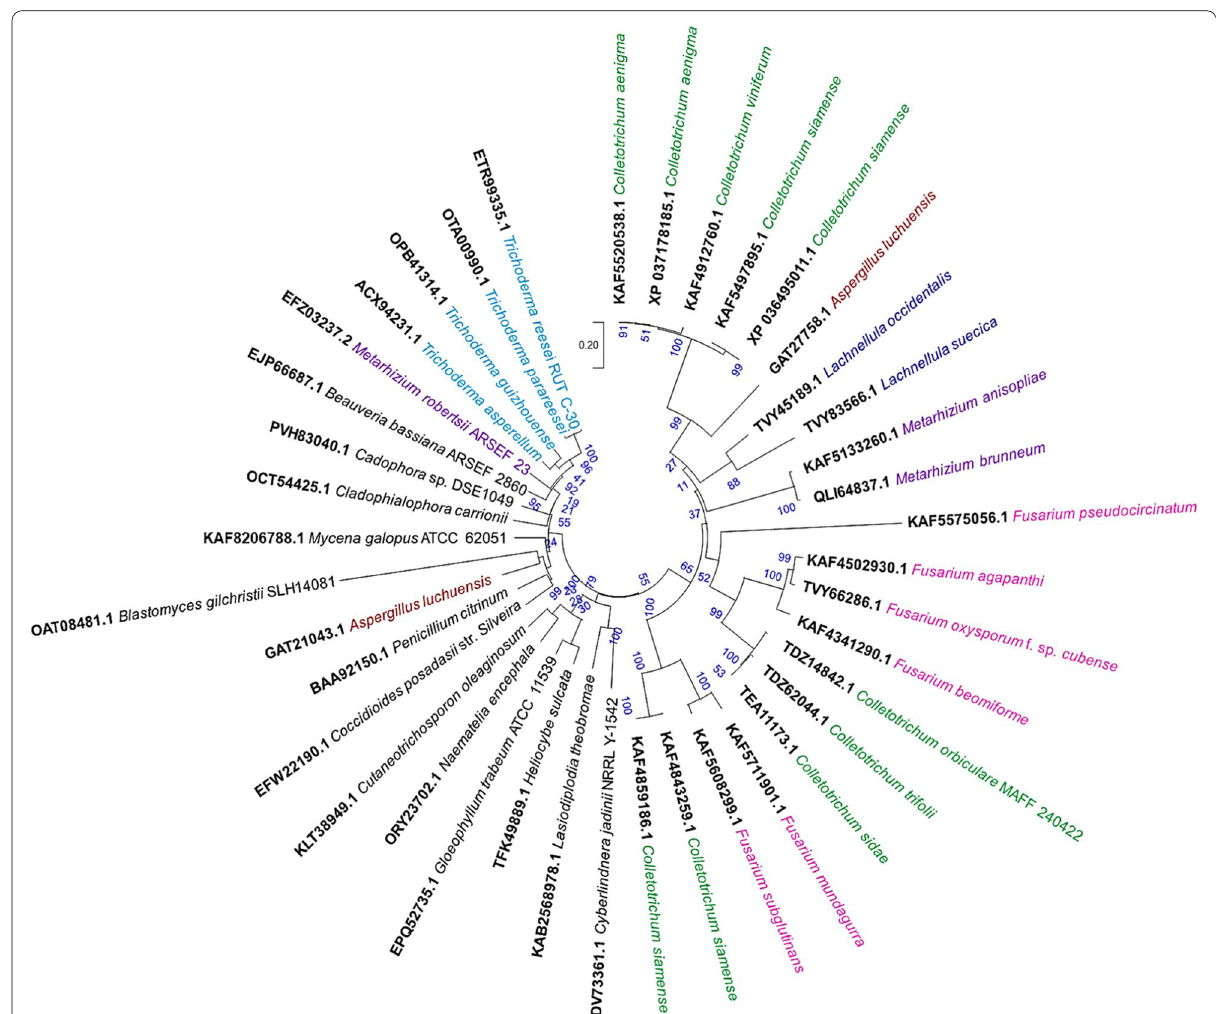
Fig. 1 Sequence homology-based phylogenetic tree of selected fungal ACC deaminase sequences. The tree was inferred in MEGA X using the Neighbor-Joining method with 1000 bootstraps. The evolutionary distances were computed using the Poisson correction